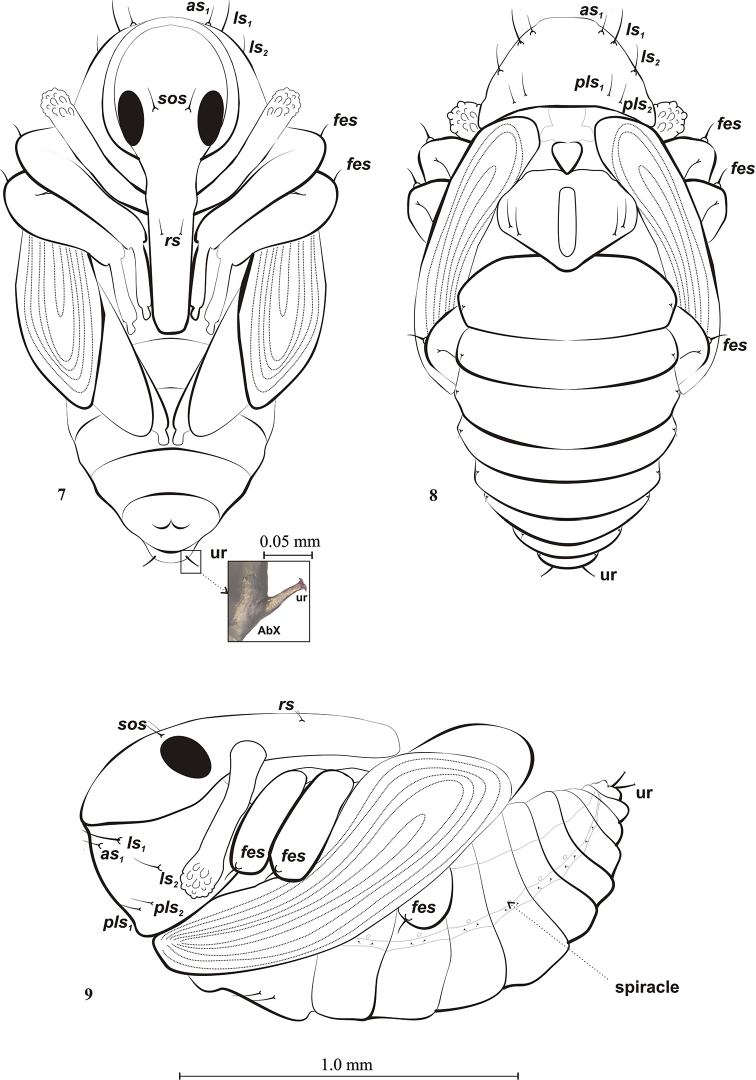
Pupa of Squamapion
atomarium7 ventral view 8 dorsal view 9 lateral view.